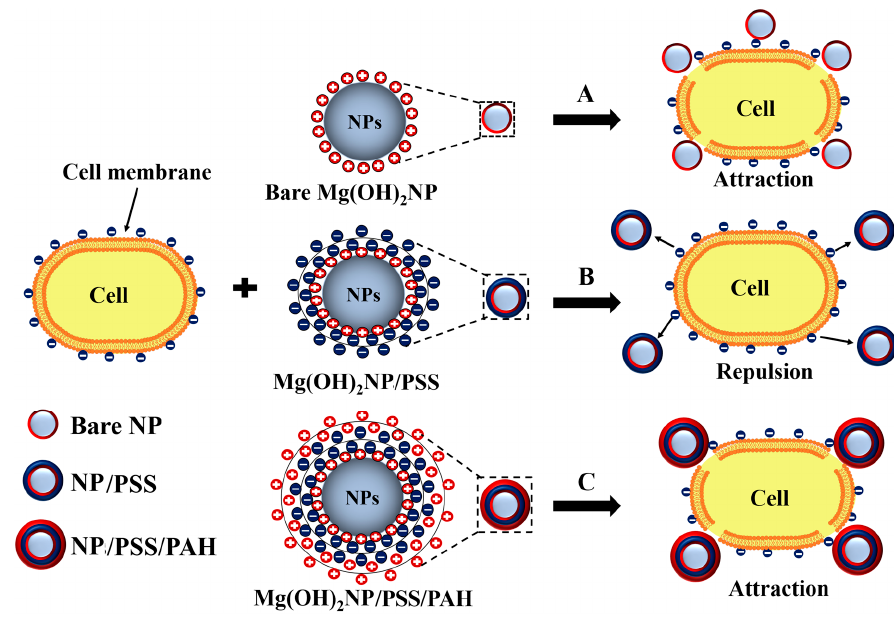
Figure 1. Schematic diagram showing the various contacting patterns between the bare and polyelectrolyte-coated Mg(OH) 2 NPs on cells. ( A and C ) The adhesion of the uncoated and cationic polyelectrolyte-coated Mg(OH) 2 NPs to the cell wall surfaces is favoured due to their opposite surface charges. ( B ) The interaction between the anionic outer surface of the cell membrane and the Mg(OH) 2 NPs coated with anionic polyelectrolyte is repulsive. The cationic Mg(OH) 2 NPs and Mg(OH) 2 NPs/PSS/PAH nanoparticles are expected to be more effective against the microbial cells than the anionic Mg(OH) 2 NPs/PSS particles.